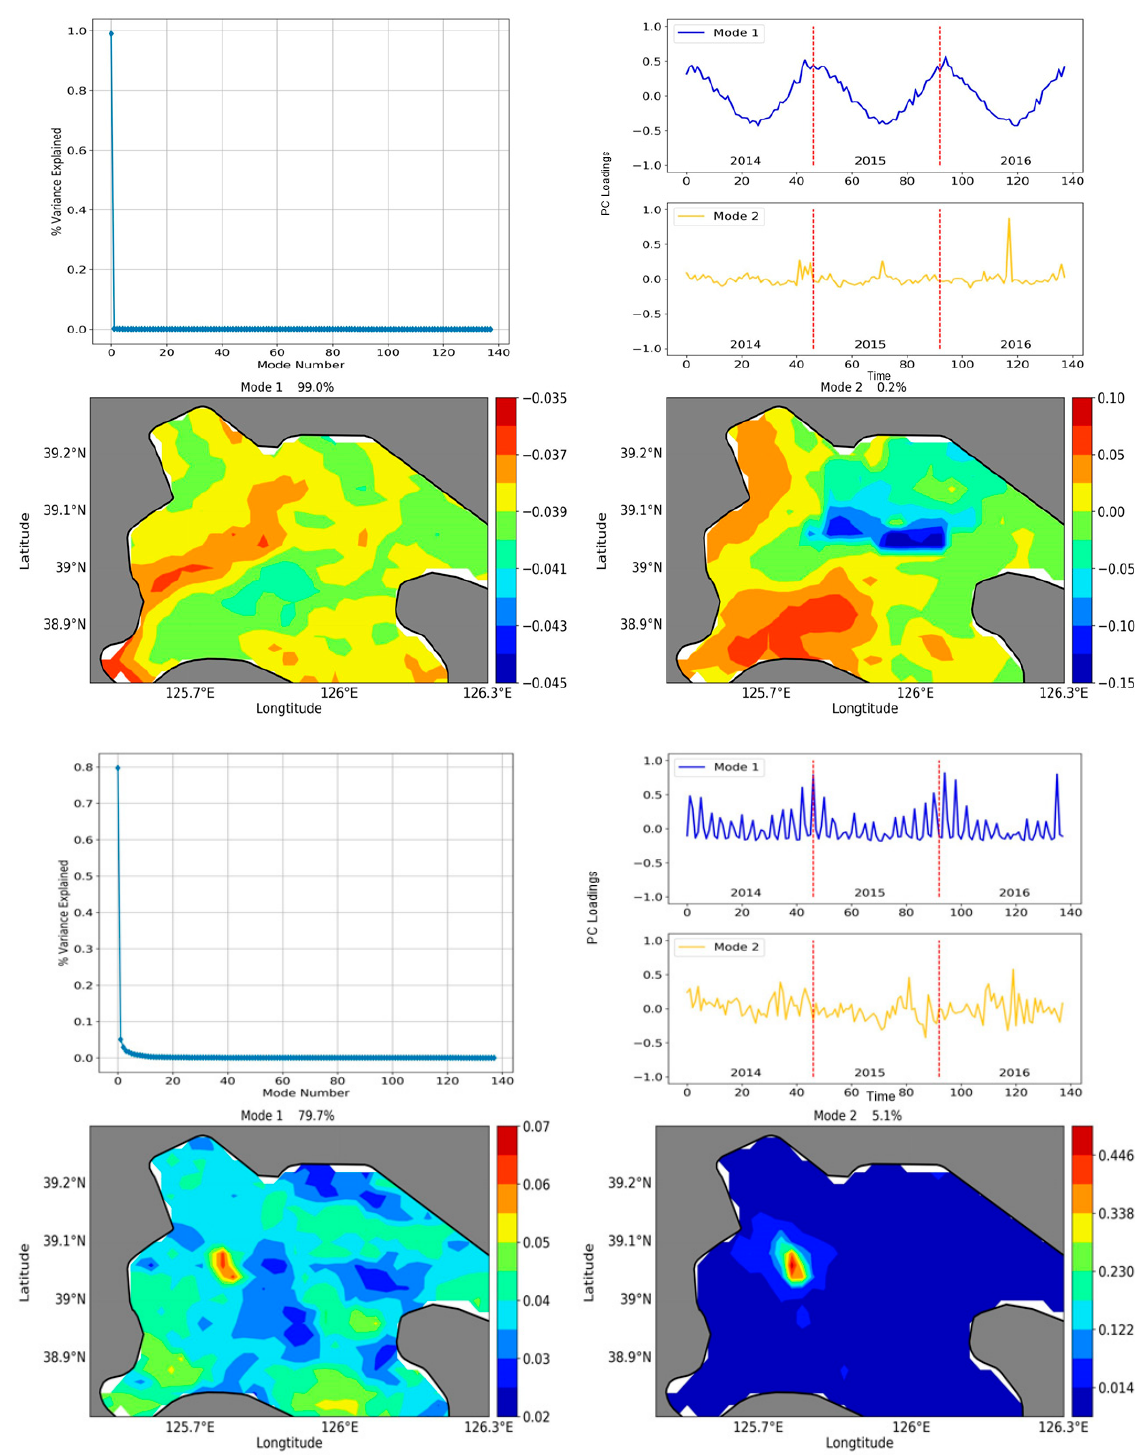
Figure 6. The S-mode PCA results for LST and DNB data in Pyongyang. The first four panels show the LST results and the last four panels show DNB results.